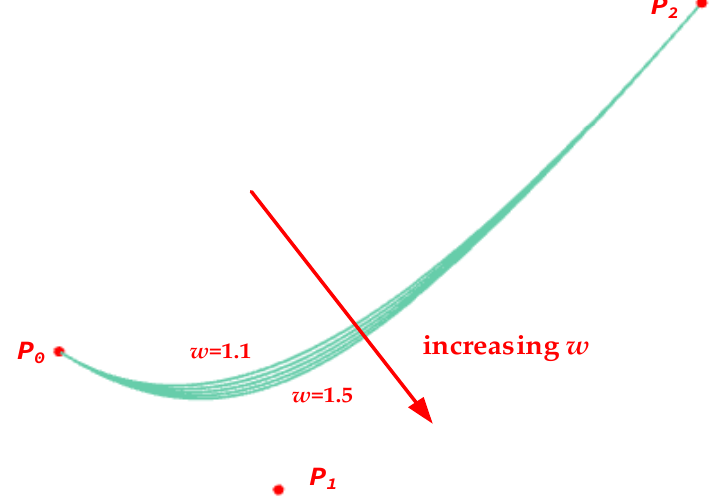
Figure 11. Changing curve shape by changing weighting factor.